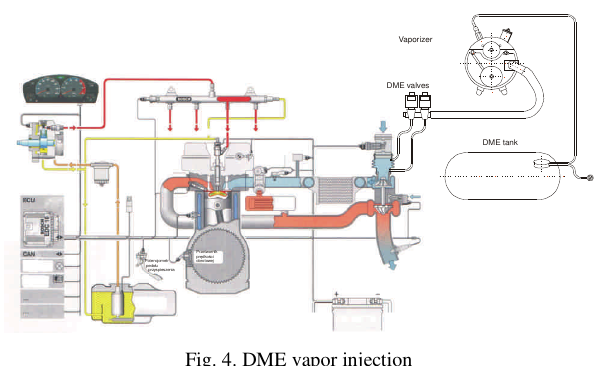
Fig. 4. DME vapor injection